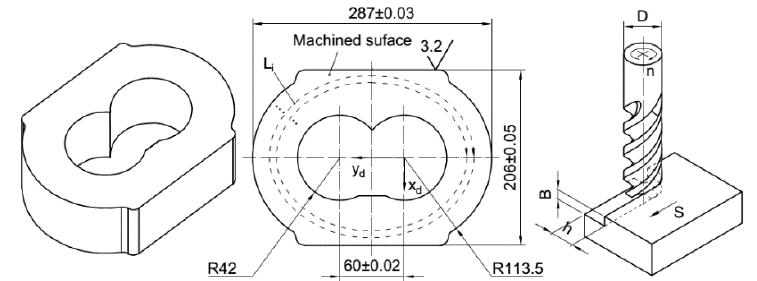
Figure 8. The workpiece and the tool path.